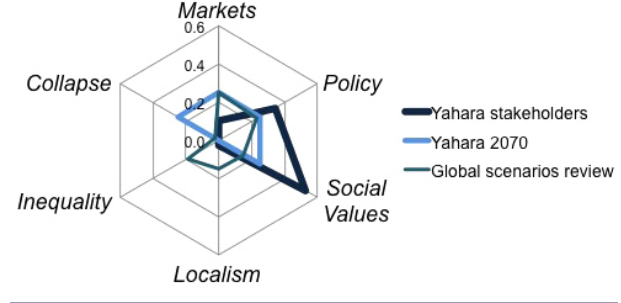
Fig. 3 . Comparison of proportions of primary change themes for Yahara stakeholders, Yahara 2070 scenarios, and global scenarios review. Proportions (represented on a scale of 0-0.6) were calculated from the number of interviewees or scenarios describing a theme as primary over the total (38 interviewees, 4 Yahara 2070 scenarios, 124 global scenarios).